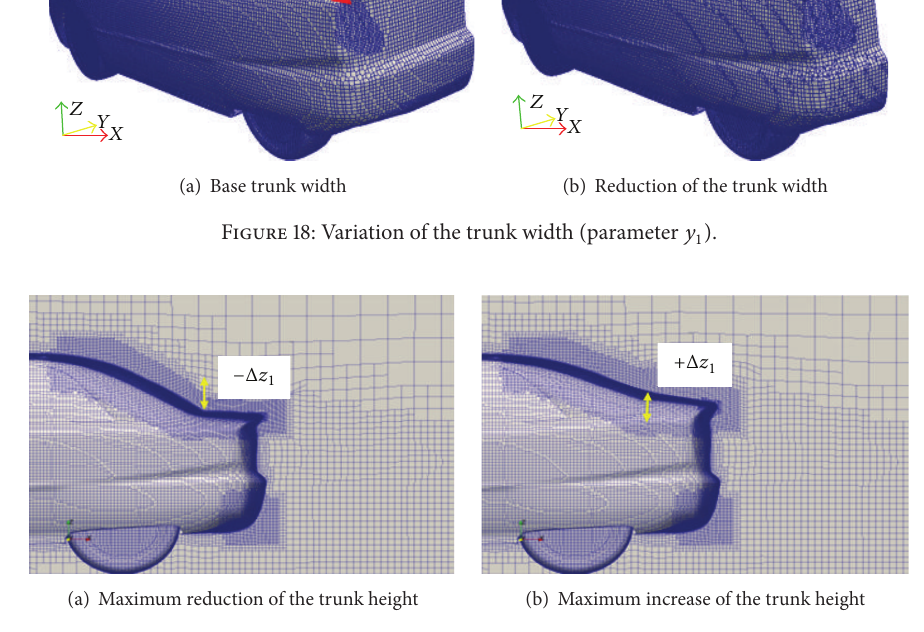
Figure 19: Variation of the trunk height (parameter 𝑧 1 ).